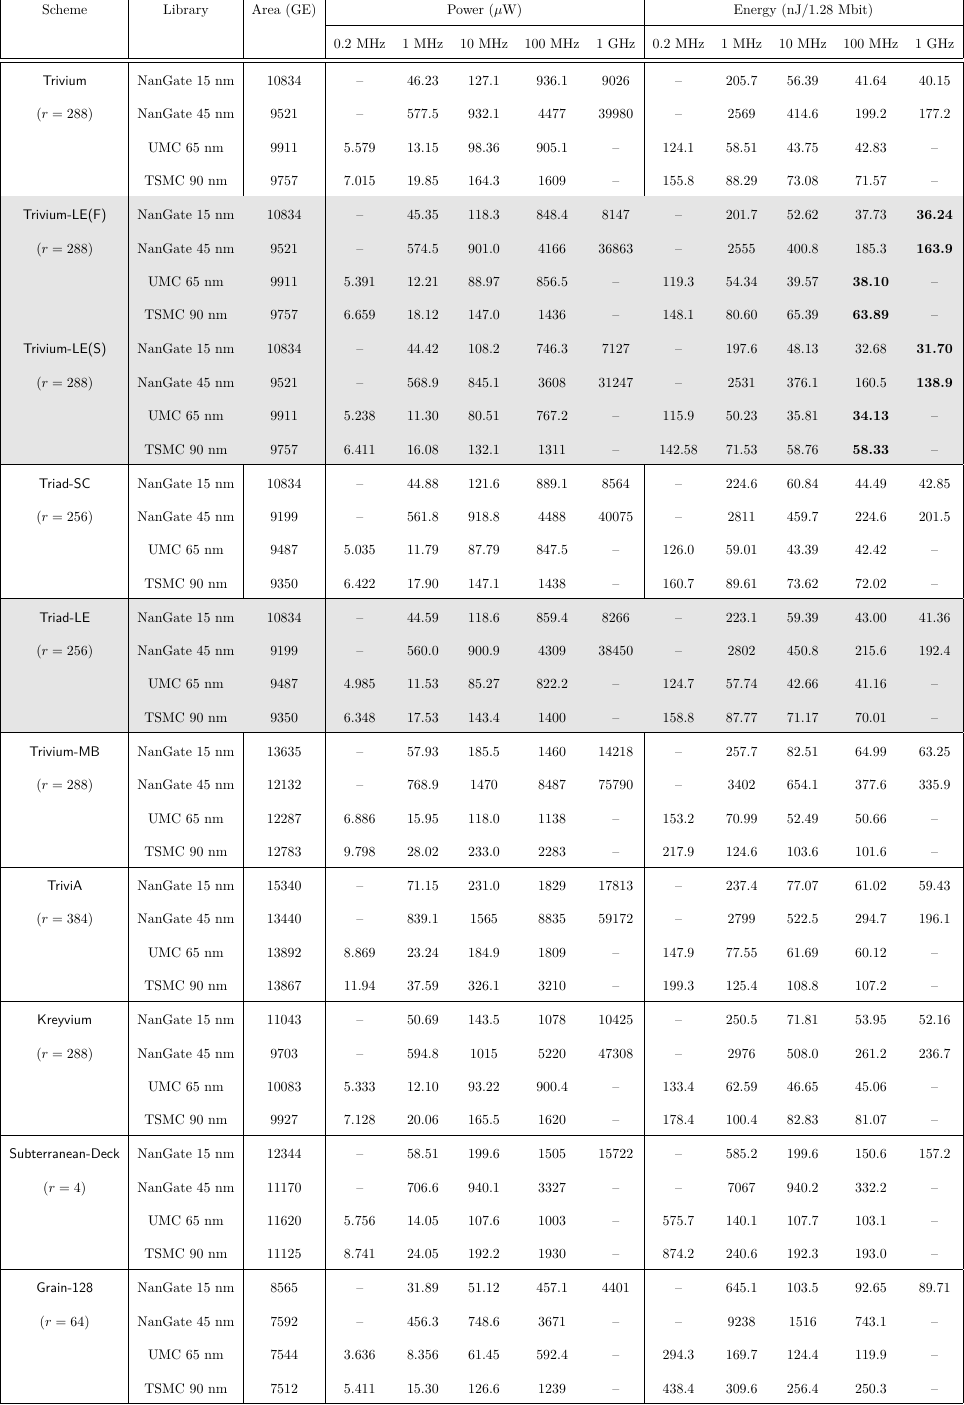
Table 3: Measurements summary for all investigated stream